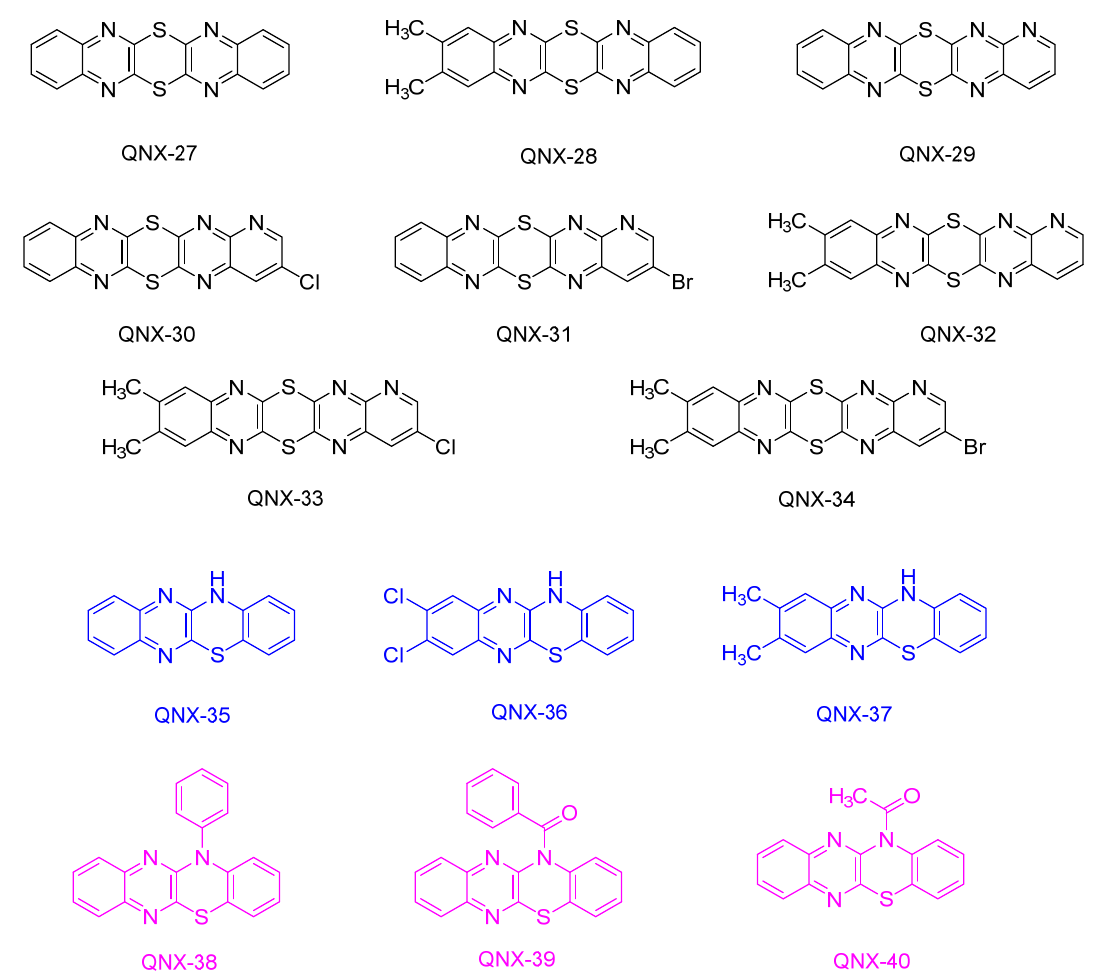
Figure 30. Chemical structures of different sulfur-containing quinoxalines.